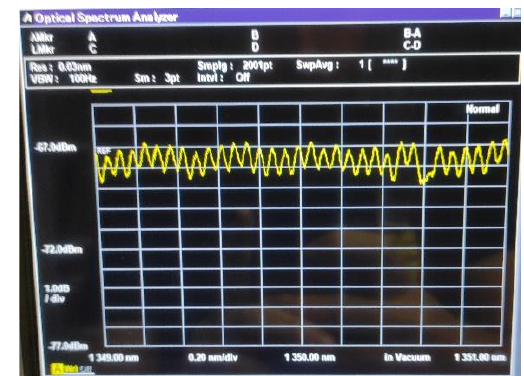
Figure 2: Example of a channeled spectrum obtained from the